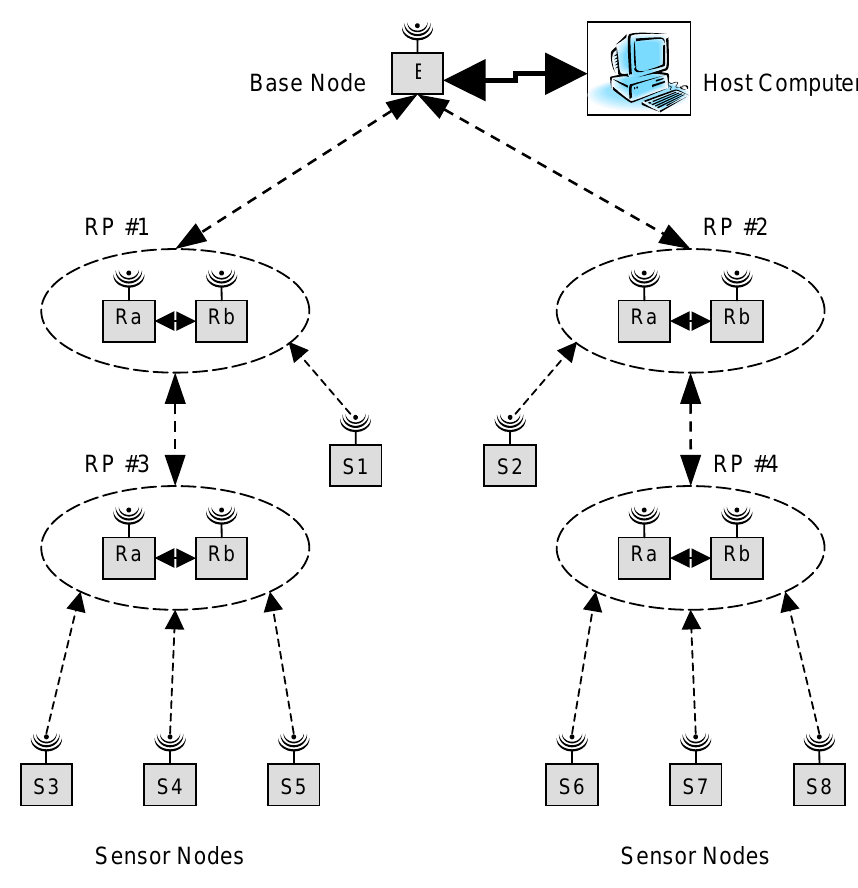
Figure 2. Network